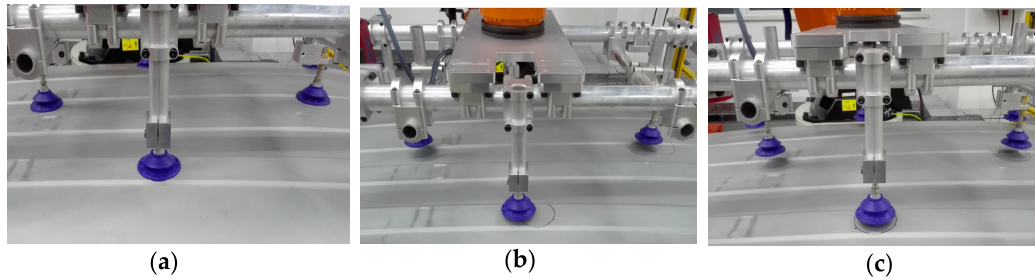
Figure 8. Status of the gripper: ( a ) Initial part with initial path; ( b ) Moved part with initial path; ( c ) Moved part with corrected path.